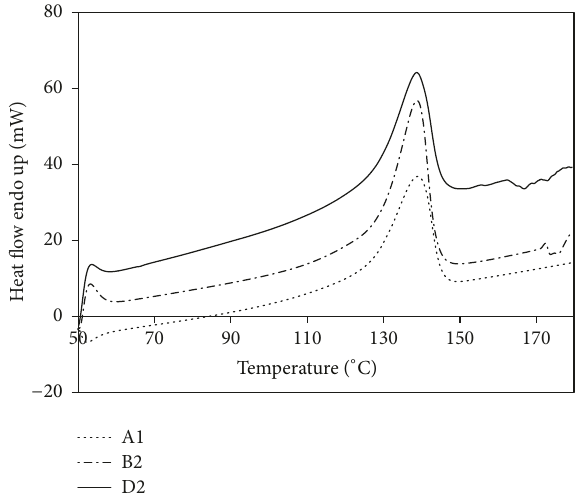
Figure 3: DSC curves of composites types A1, B2, and